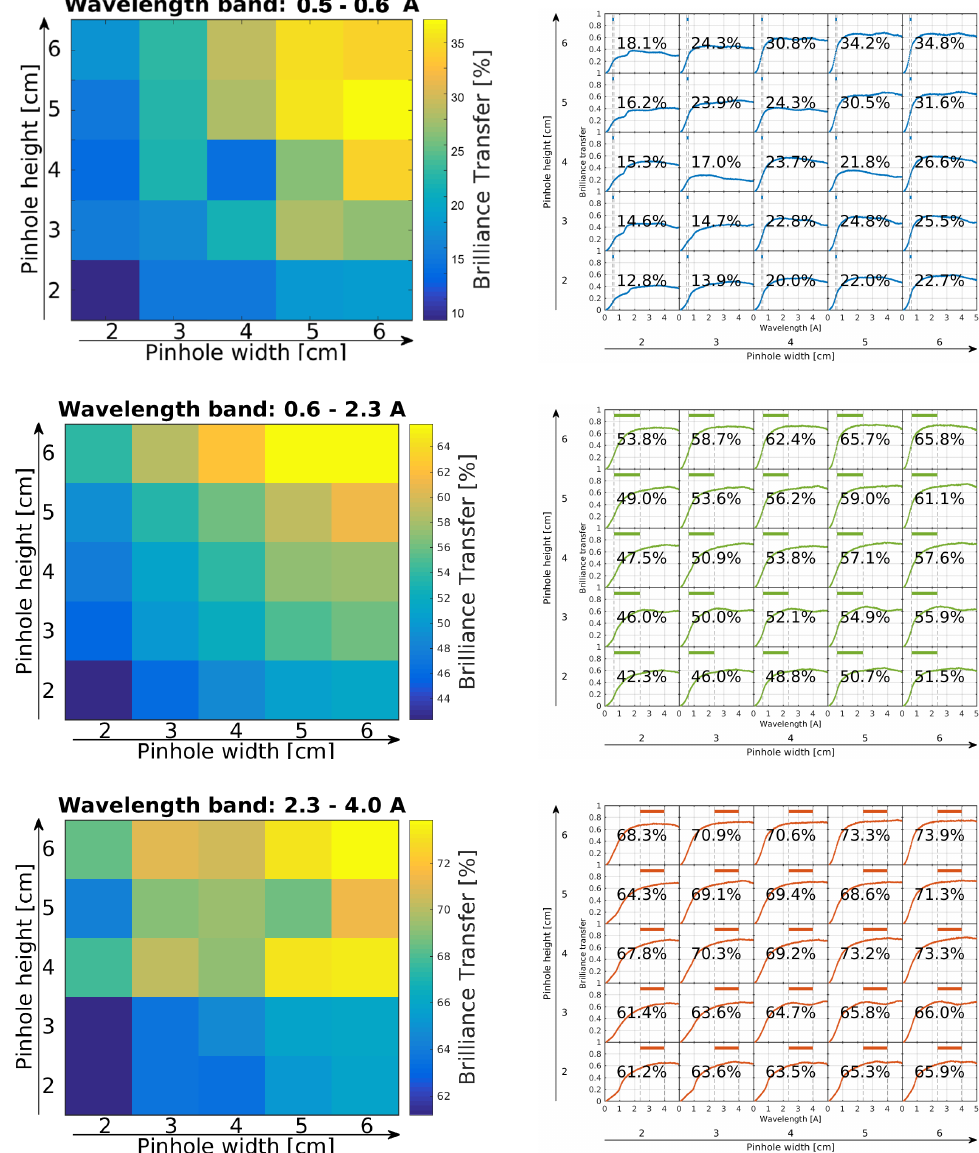
Figure A2. Left panels: Average values of BT , given as a color code. Both graphs are shown for 5 values of rectangular pinhole height (vertical displacement) and 5 values of pinhole width (horizontal displacement). Right panels: Simulated values of BT as a function of neutron wavelength (in the range 0–5 Å) for guides optimized for 0.5–0.6 Å (blue curves), 0.6–2.3 Å (green curves), and 2.3–4.0 Å (red curves). The number on each graph displays the average BT value within the relevant wavelength